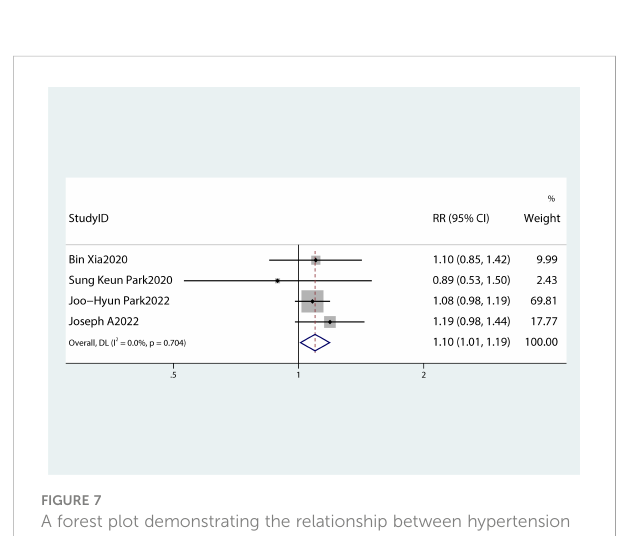
FIGURE 7 A forest plot demonstrating the relationship between hypertension and the risk of pancreatic cancer.